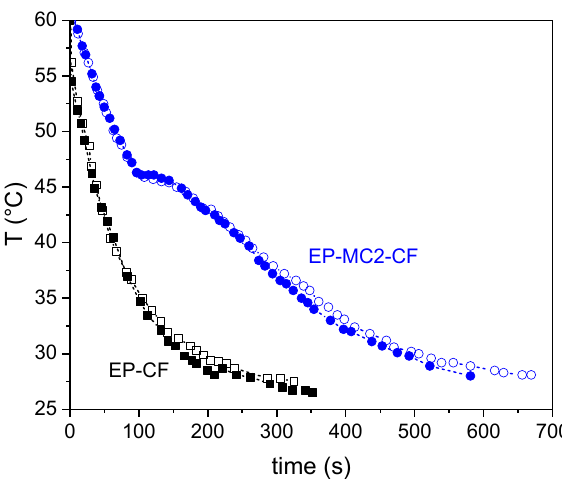
Figure 13. Results of the thermal camera test on the prepared laminates. For reach laminate, the test was repeated on both sides.